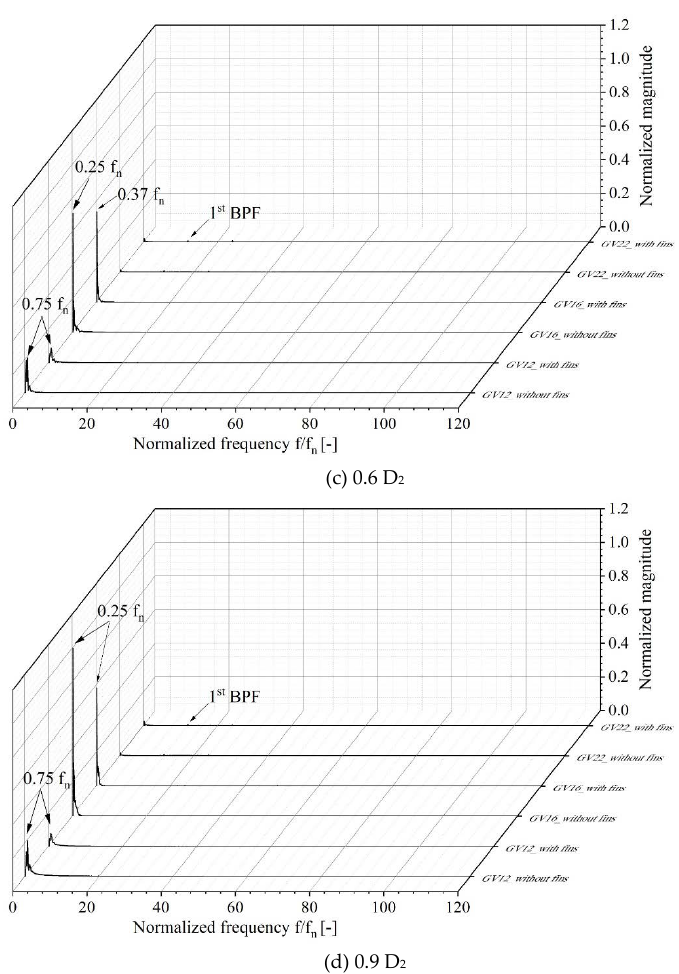
Figure 17. Normalized unsteady pressure characteristics along the flow direction in the DT: (a) 0.1, (b) 0.3, (c) 0.6, and (d) 0.9 D 2 .